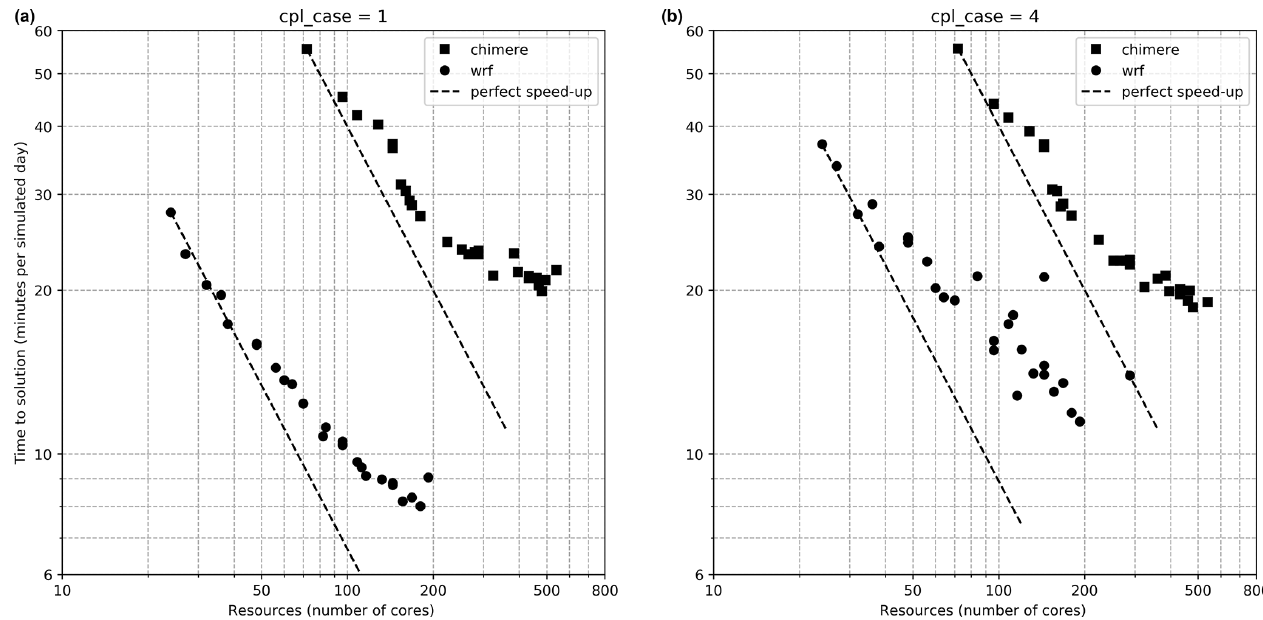
Figure 16. Time to solution of WRF and CHIMERE in minutes per simulated day as a function of computational resources for cpl _ case = 1 (a) and cpl _ case = 4 (b)